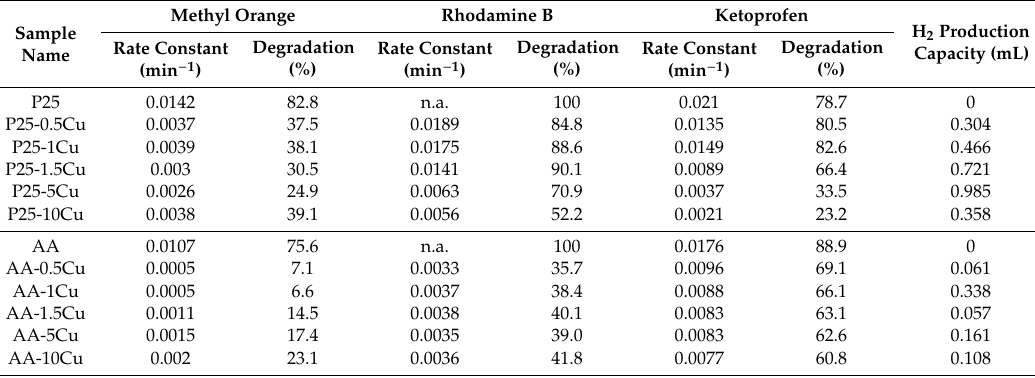
Figure 7. Photocatalytic degradation e ffi ciencies of Rhodamine B solution under UV light—the P25-based composites showed better activity than the AA-based ones. Table 2. Conversion vs. reaction rate constant for all the investigated